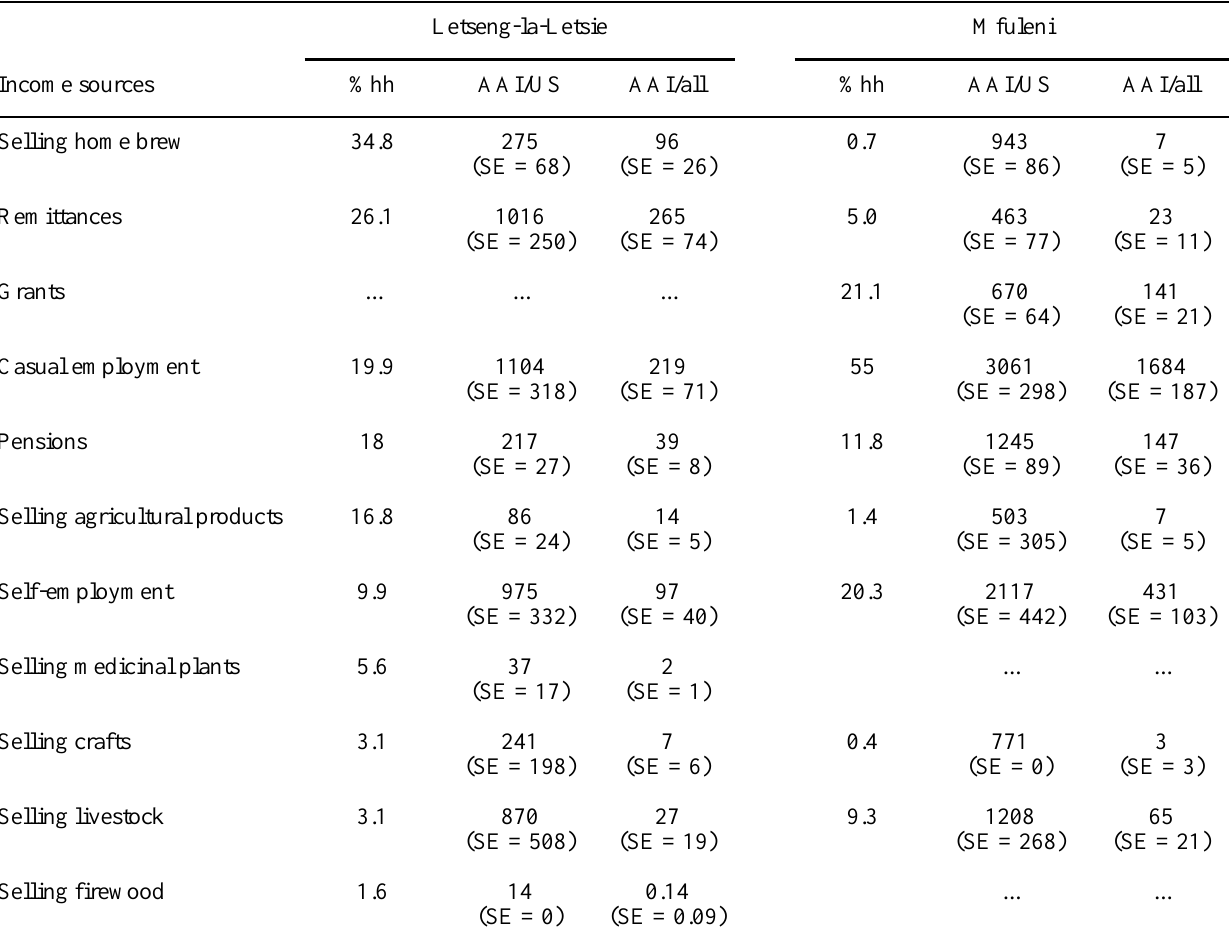
Table 1 . Sources of cash income and percentage of households receiving incomes from these sources around Letseng-la-Letsie ( n = 161) and Mfuleni ( n = 279); hh = households, AAI/US = annual average income for households earning U.S. dollars, and AAI/all = average annual income for all households. Letseng-la-Letsie Mfuleni Income sources %hh AAI/US AAI/all %hh AAI/US AAI/all 34.8